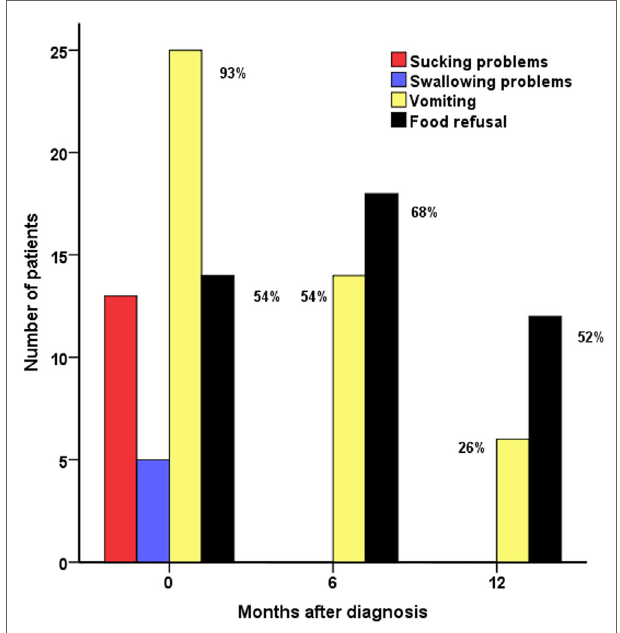
FigUre 1 | Feeding problems (FPs) in chi patients ( n = 28): sucking problems, swallowing problems, vomiting, and food refusal at diagnosis and at 6 and 12 months in follow-up